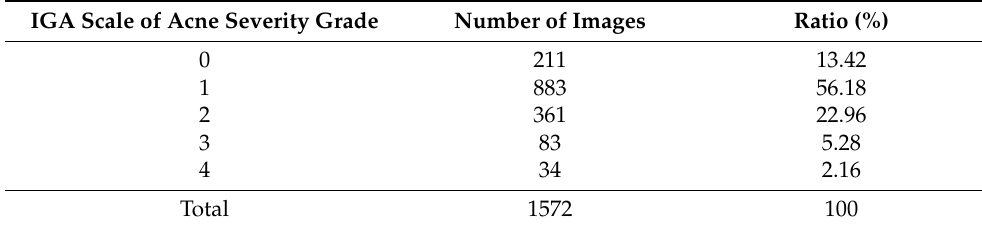
Table 2. Statistics of different acne severity grades based on the IGA scale.